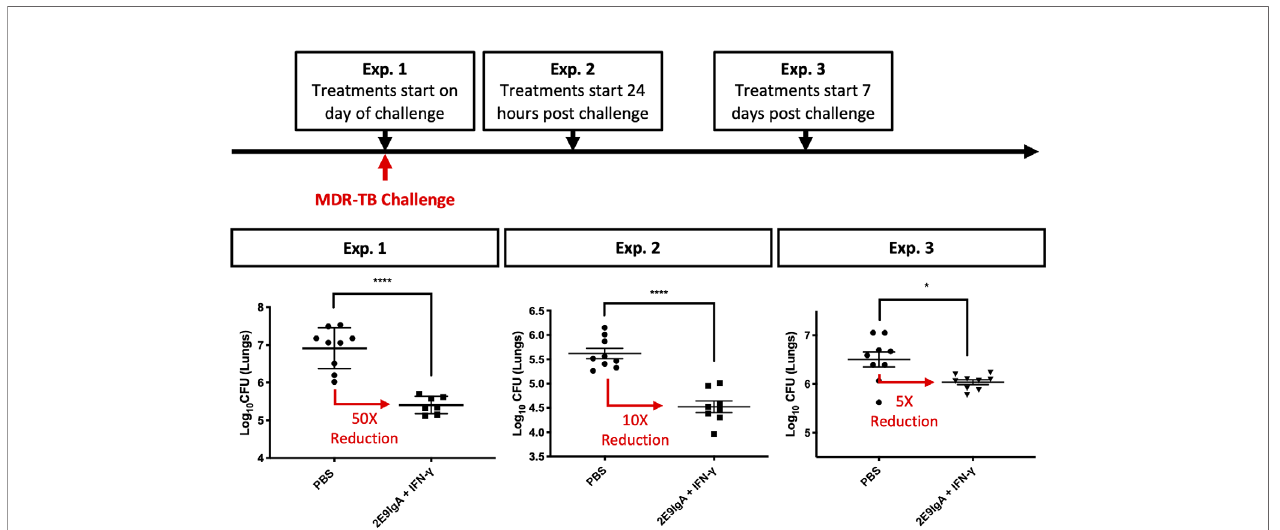
FIGURE 3 | CIT treatment of aerosol MDR-TB challenge in CD89 transgenic mice. CD89 transgenic BALB/c mice were challenged with 100 – 200 CFU MDR-TB by the nose-only aerosol challenge method. Animals were given treatment of 50 µg/animal 2E9IgA1 + 1 µg/animal IFN- g (CIT) either on the day of challenge (Exp.1), 24 h post challenge (Exp. 2) or 7 days post challenge (Exp. 3), with the two subsequent intranasal doses at three-day intervals. Animals were culled at 3 weeks post- challenge and lung CFU were enumerated. Error bars indicate SEM. *p ≤ 0.05, ****p0.0001 as determined by one-way ANOVA with Tukey ’ s correction; n = 8. Three independent